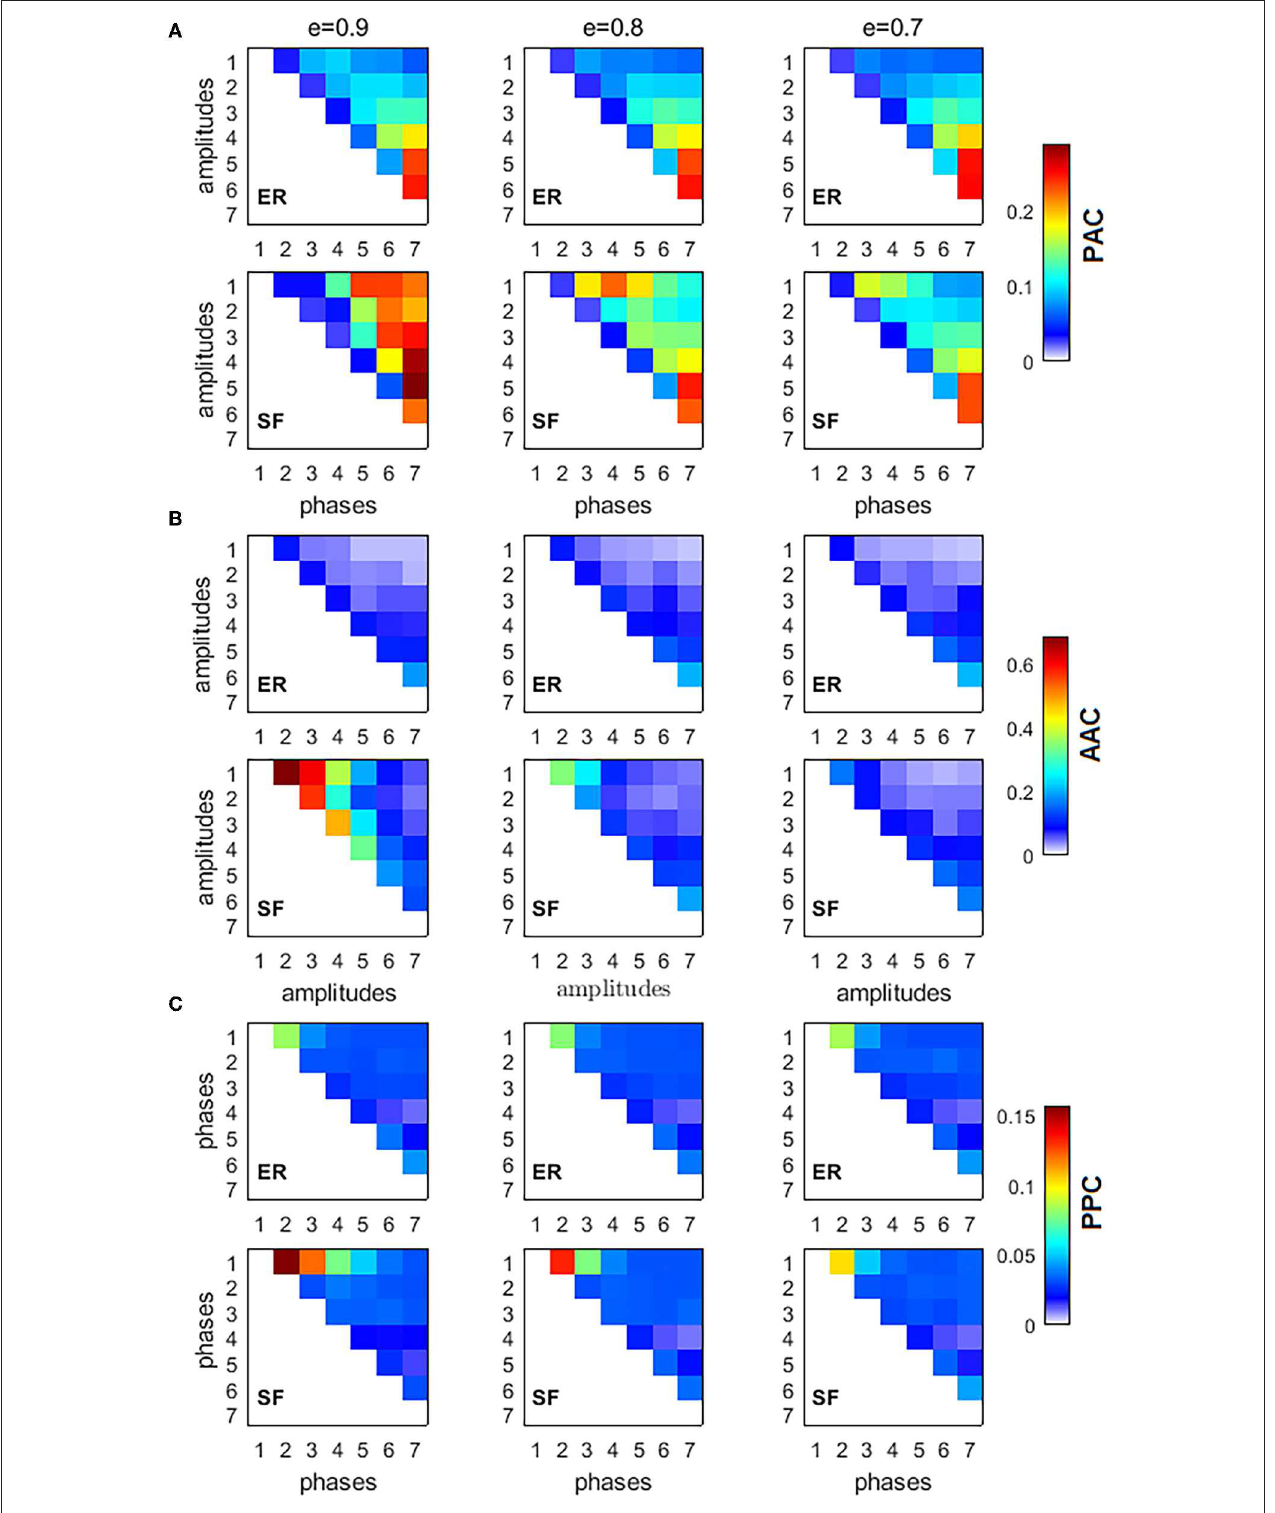
FIGURE 2 | Cross-frequency interactions between the fundamental modes of information flow in ER and SF networks. All simulated networks had N = 500 nodes, and 10 4 random walkers were placed over them, each performing 5,000 time steps. Three different values of network sparsity were considered: e = [ 0.9, 0.8, 0.7 ] . (A) phase-amplitude coupling (PAC), (B) amplitude-amplitude coupling (AAC), (C) phase-phase coupling (PPC).